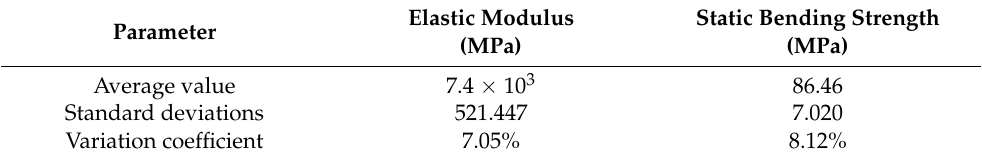
Table 2. Mechanical properties of bamboo